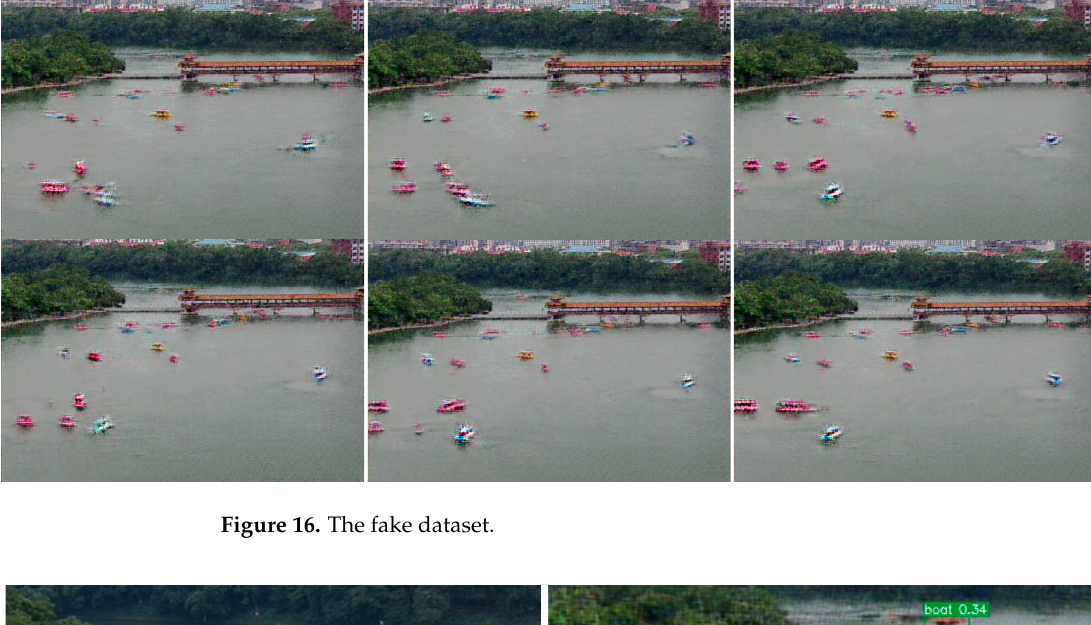
Figure 15. The custom dataset.